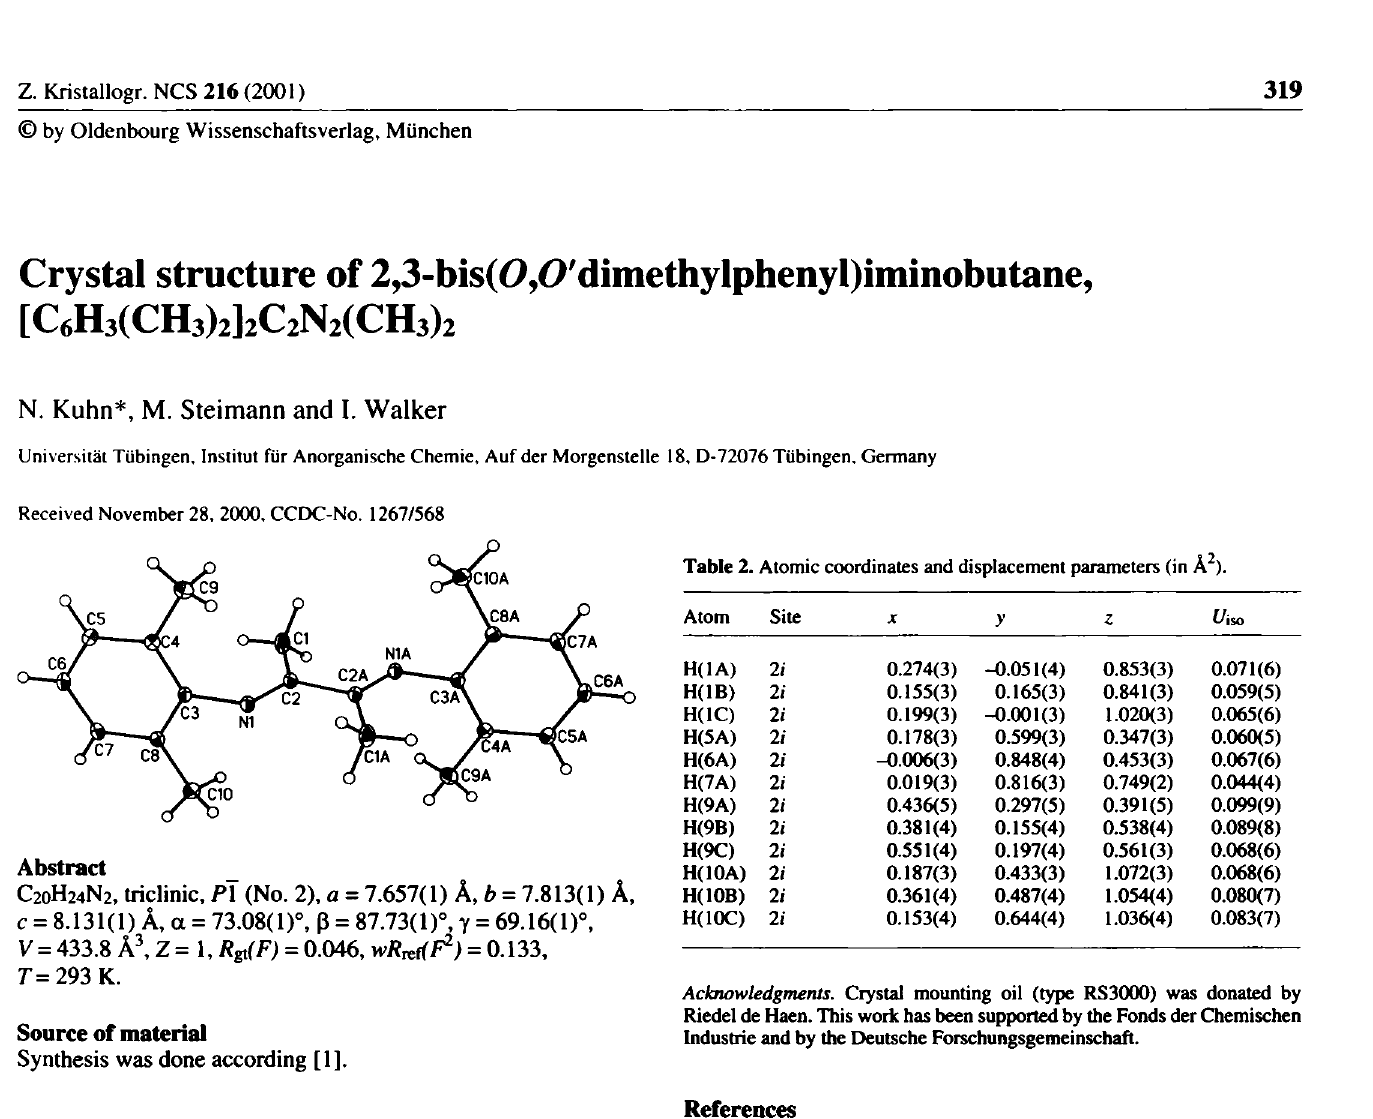
Table 1. Data collection and handling.